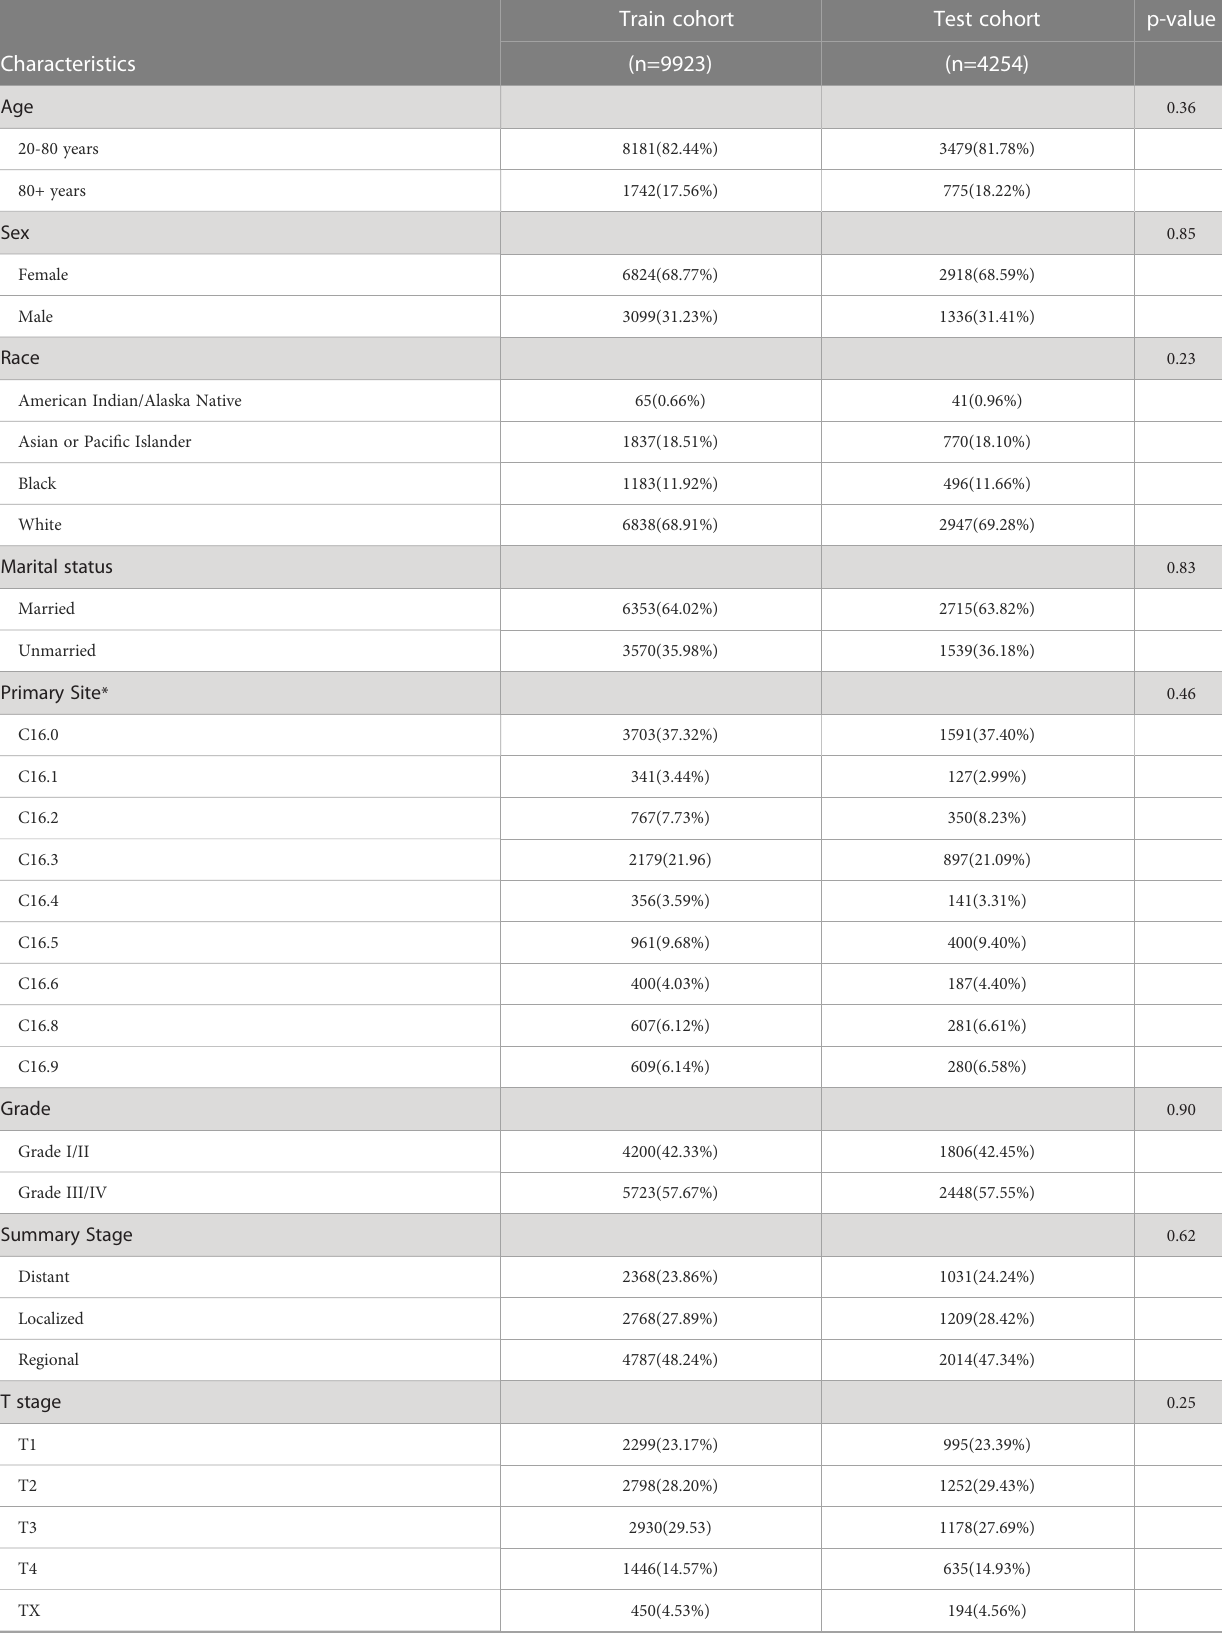
TABLE 1 Clinical and pathological features of patients with gastric